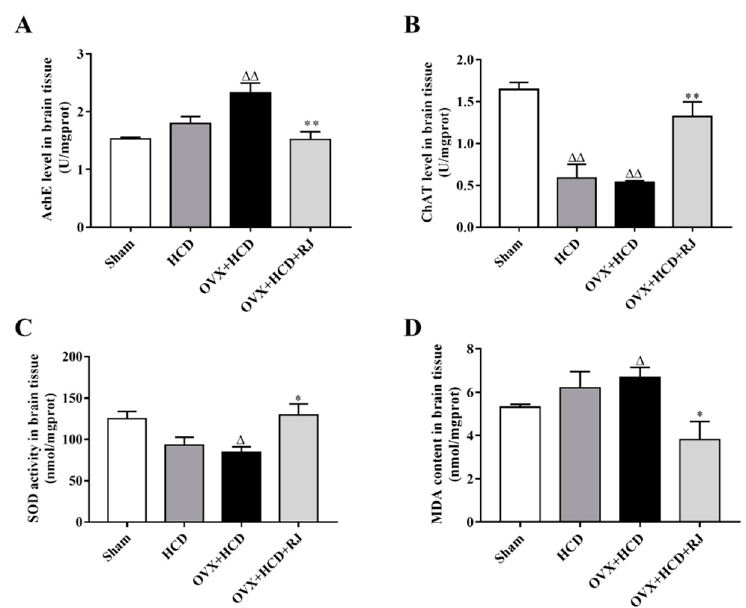
Figure 4. RJ enhanced cholinergic system activities and antioxidant abilities in the brain of ovariectomized cholesterol-fed rabbits. Ache level ( A ), ChAT level ( B ), SOD activity ( C ), and MDA content ( D ) were detected in the brain of each group. Data are expressed as mean ± SEM. n = 4–5. Compared with Sham group, ∆ P < 0.05, ∆∆ P < 0.01; Compared with OVX + HCD group, * P < 0.05, ** P < 0.01.